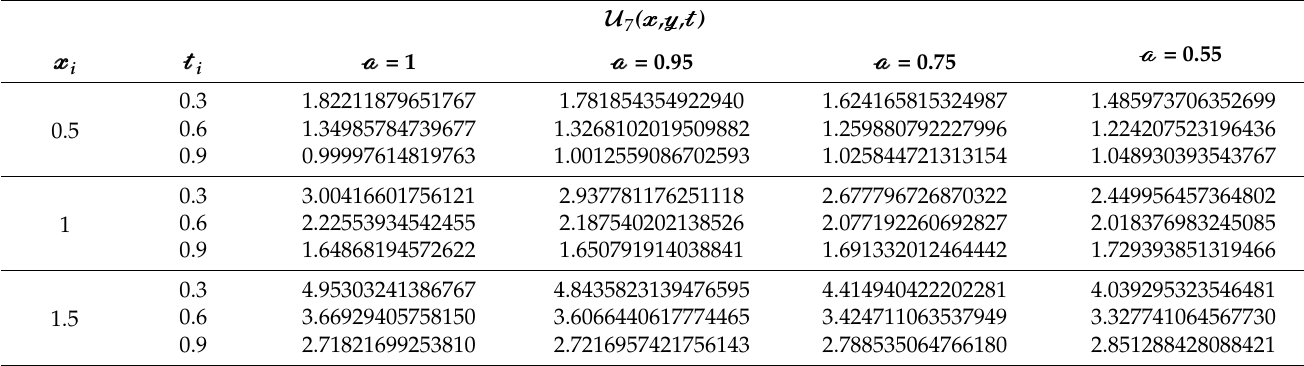
Table 6. Numerical results of approximated solutions, at y = 0.4 and different values of 𝓍 , 𝓉 , and 𝒶 , with n = 7 for Example